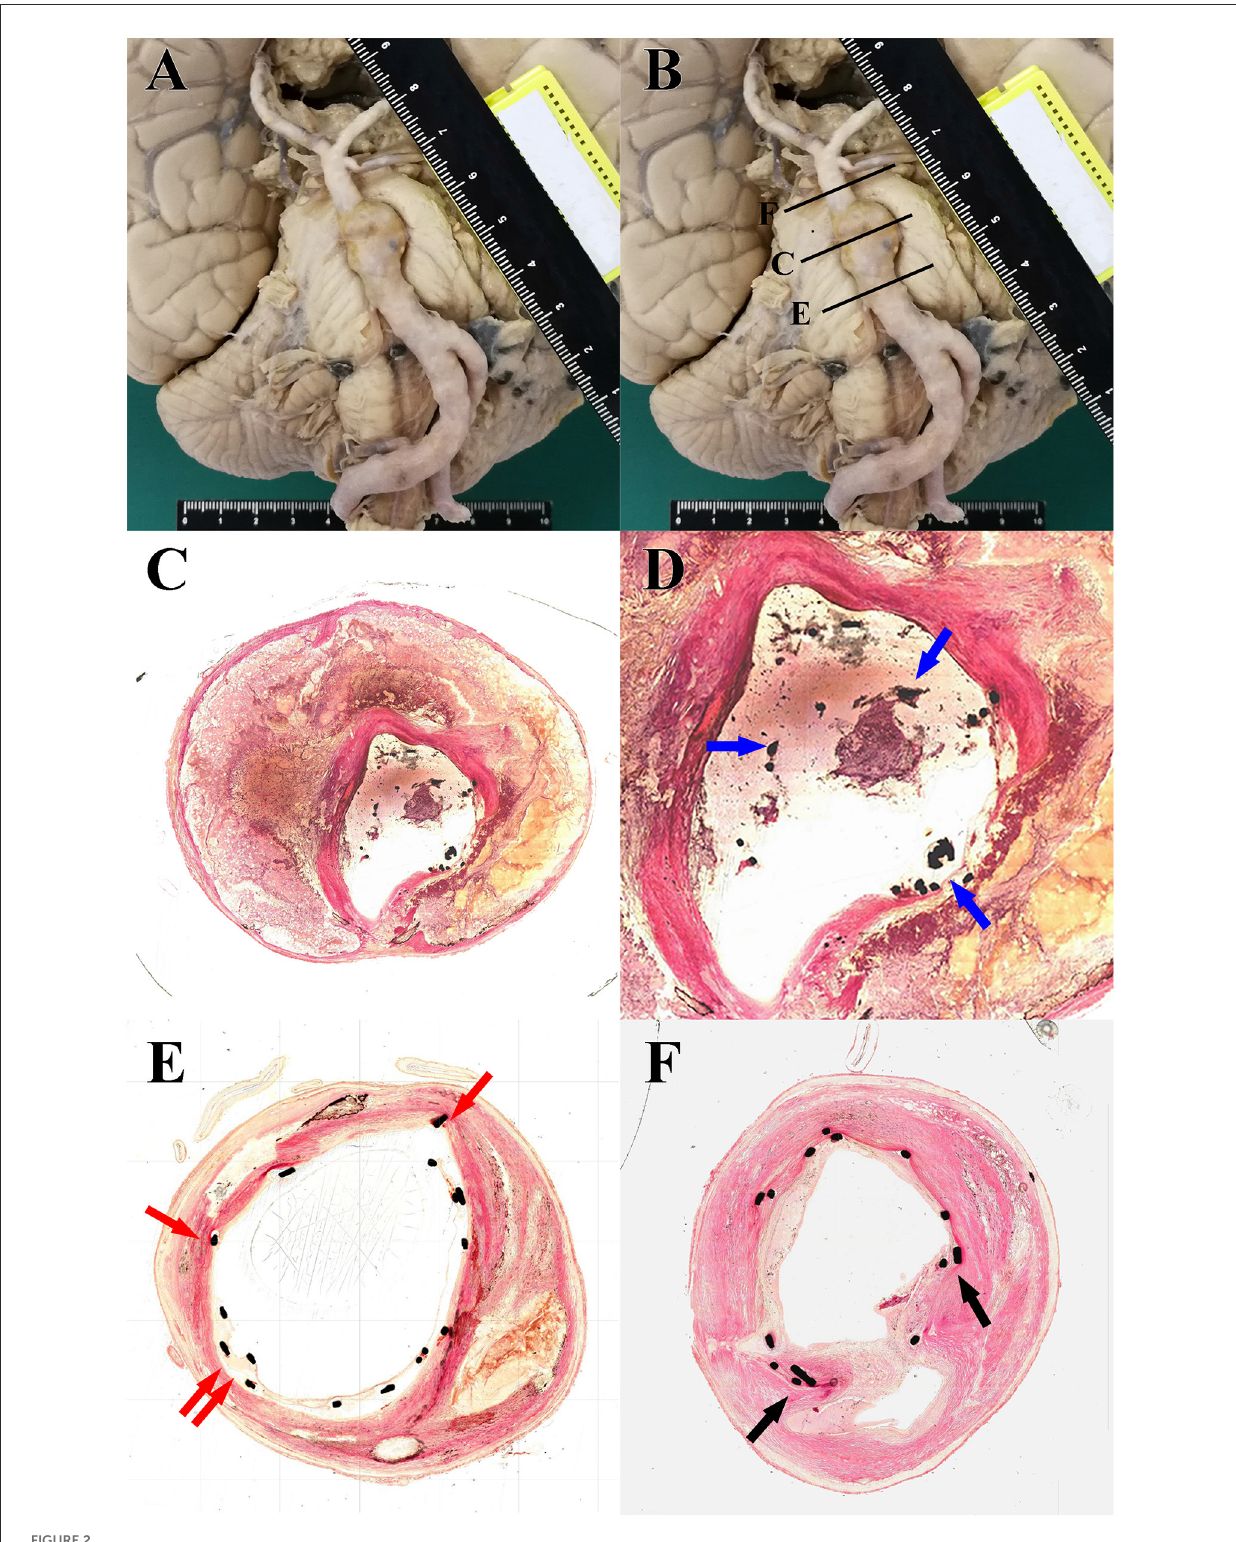
FIGURE2 (A) Gross specimens of the vertebrobasilar system showed ectasia, elongation, and tortuosity of the vertebrobasilar artery accompanied by brain stem compression caused by VBD. (B) Schematic diagram of tissue slice position: the proximal region (E), distal region (F), and apparent dilatated region (C). (C) Light microscopy images from H–E staining (20 × ) of tissue slice of the apparent dilatated region: irregular intravascular lumen, loss of smooth muscle, and multiple thromboses among the dissection. (D) Locally magnified images (40 × ) focusing on the intravascular lumen of the section of the apparent dilatated region showed that the stent was suspended, and there was no vascular endothelium coverage on the surface (blue arrow). (E) Light microscopy images from H-E staining (40 × ) of tissue slice of the proximal region: the stent was relatively adherent, and vascular endothelium or connective tissue coverage appeared above the stent (red arrow). (F) Light microscopy images from H–E staining (40 × ) of tissue slice of the distal region: smooth muscle coverage could be observed above the stent (black